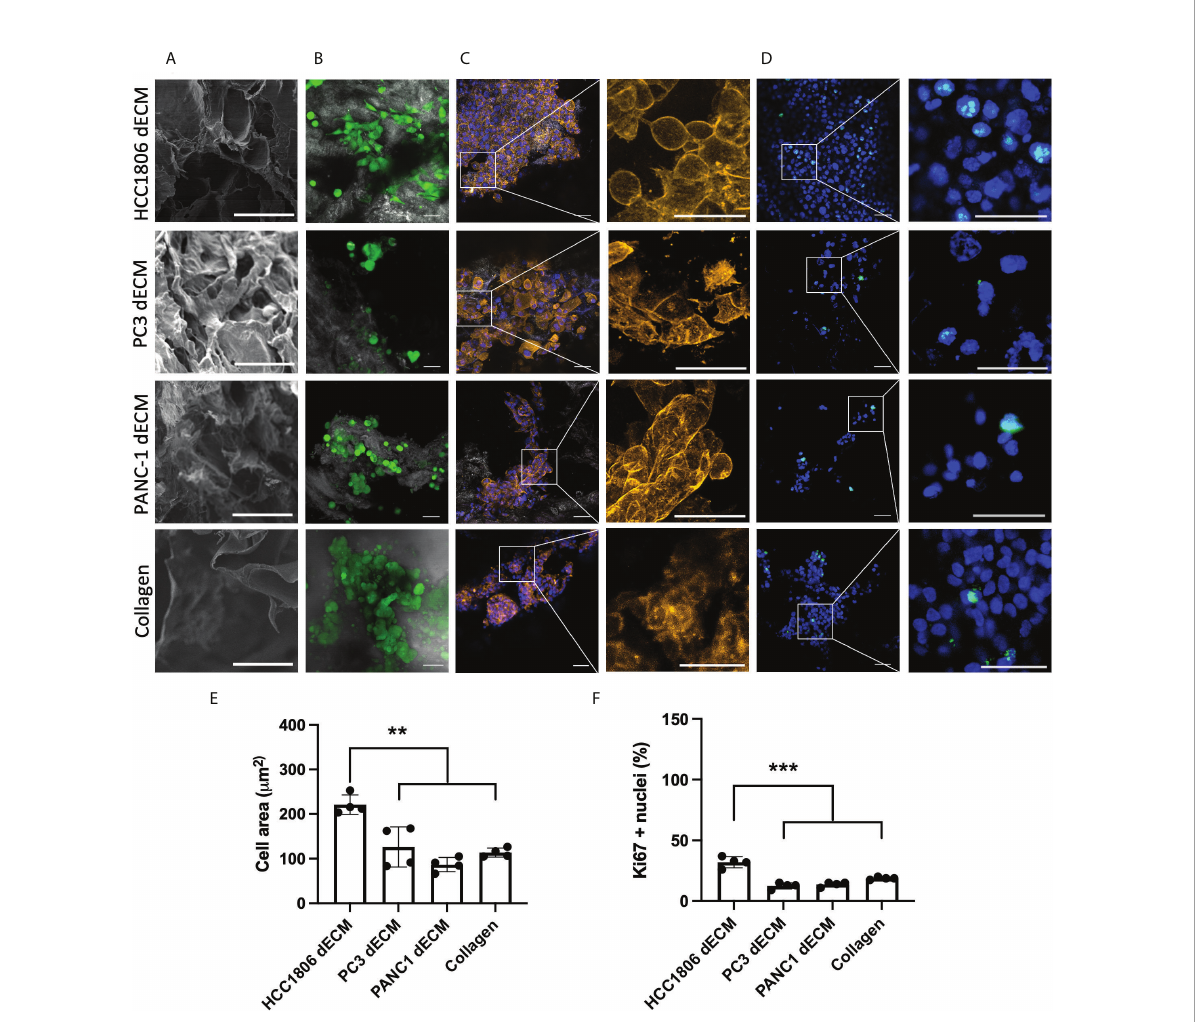
FIGURE 5 HC1806 cells show different cell behavior on HC1806 dECM compared to dECM from other tumor xenografts. (A) Detail of SEM imaging of samples showing surface structure (scale, 50 m m). (B-D) Images of cell-seeded samples. (B) Calcein-AM – positive cells are shown in green, while scaffold material is shown in grey (×20 (scale, 20 m m)). (C) Actin cytoskeleton immunostaining in orange; DAPI nuclear staining in blue (×10 (scale, 50 m m) and detailed images (scale, 20 m m)). (D) Ki67 immunostaining in green; DAPI nuclear staining in blue (×10 (scale, 20 m m) and detailed images (scale, 50 m m)). (E) Quanti fi cation of cell size (area) using actin cytoskeleton membrane distribution images. (F) Quanti fi cation of proliferative cells (Ki67-positive cells vs. total cells observed in each material). N = 3 in all cases and 2 areas measured per